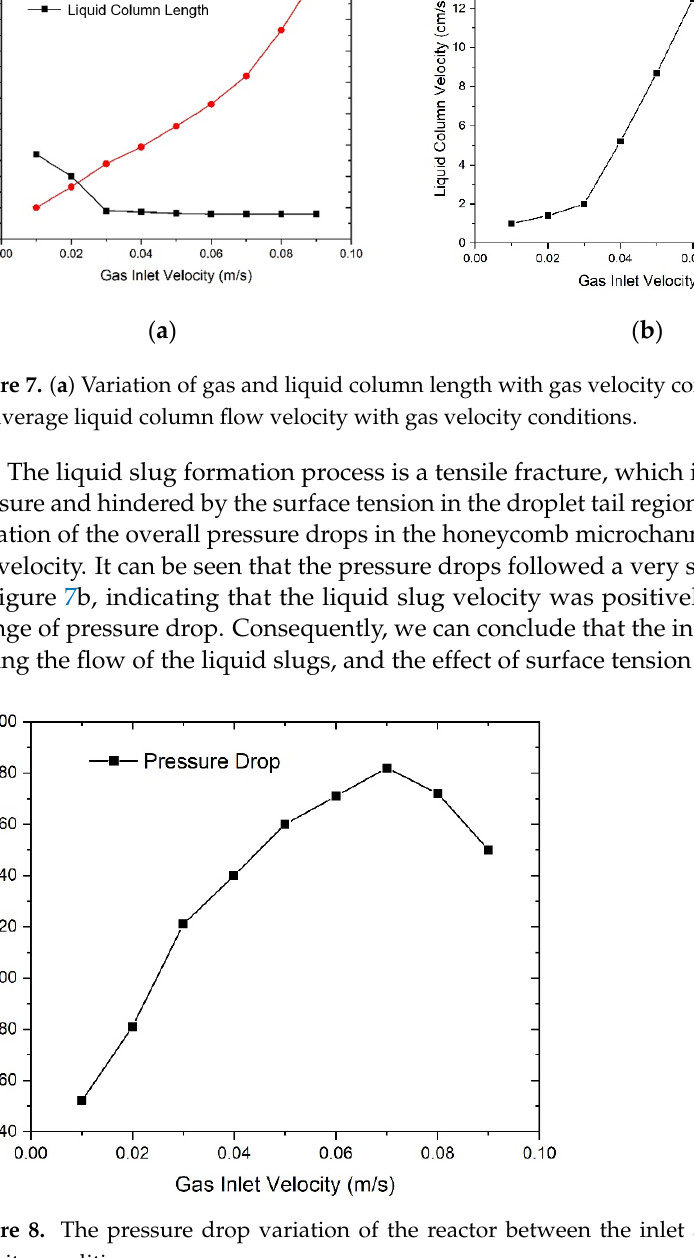
Figure 8. The pressure drop variation of the reactor between the inlet and the outlet with gas velocity conditions.